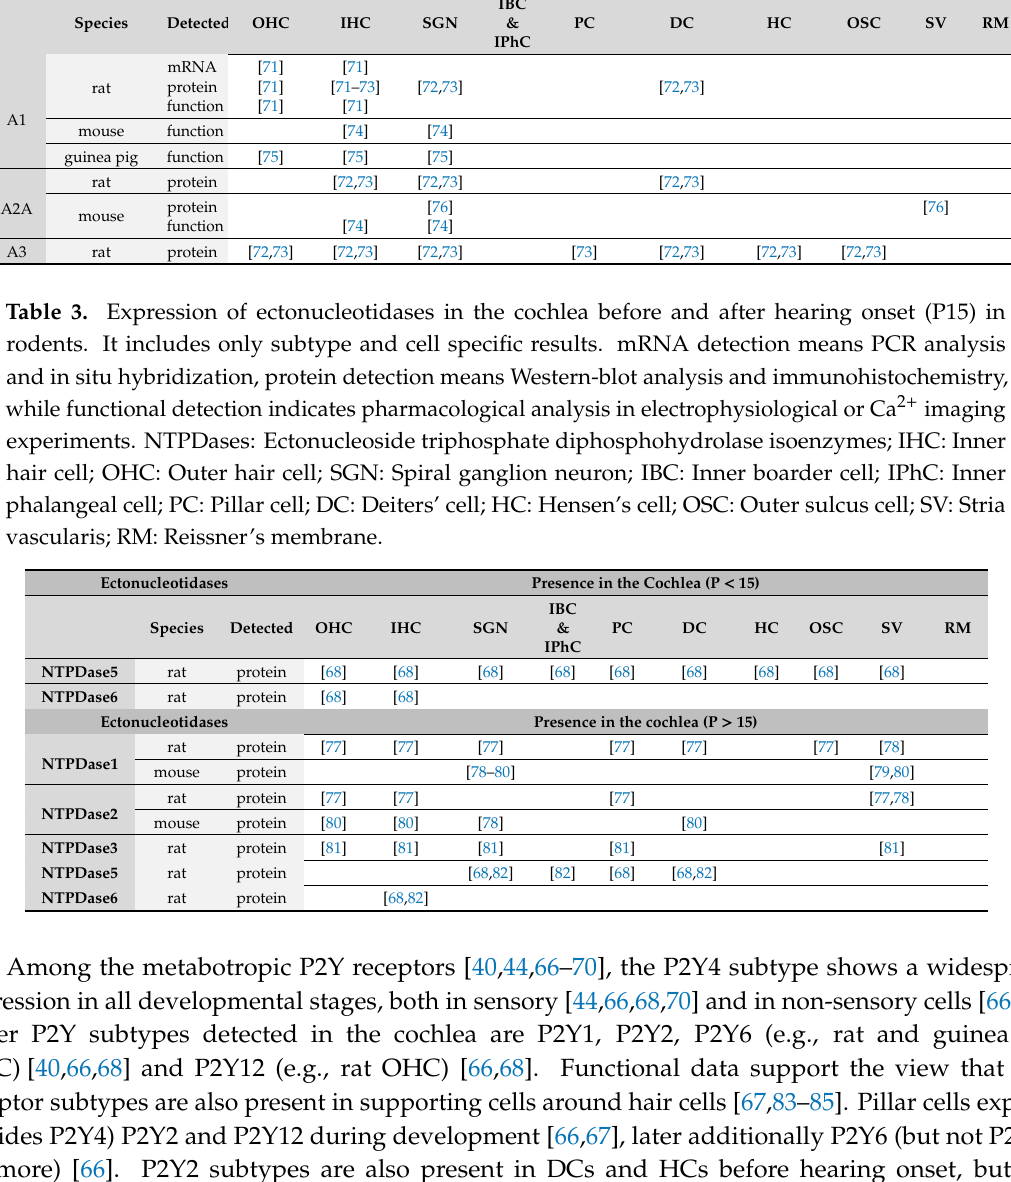
Table 2. Expression of adenosine receptors in the cochlea after hearing onset in rodents. It includes only subtype and cell specific results. mRNA detection means PCR analysis and in situ hybridization, protein detection means Western-blot analysis and immunohistochemistry, while functional detection indicates pharmacological analysis in electrophysiological or Ca 2 + imaging experiments. In case of mice and rats, results come from animals age P > 15. Results from guinea pigs are not separated by age as these animals have in utero hearing. IHC: Inner hair cell; OHC: Outer hair cell; SGN: Spiral